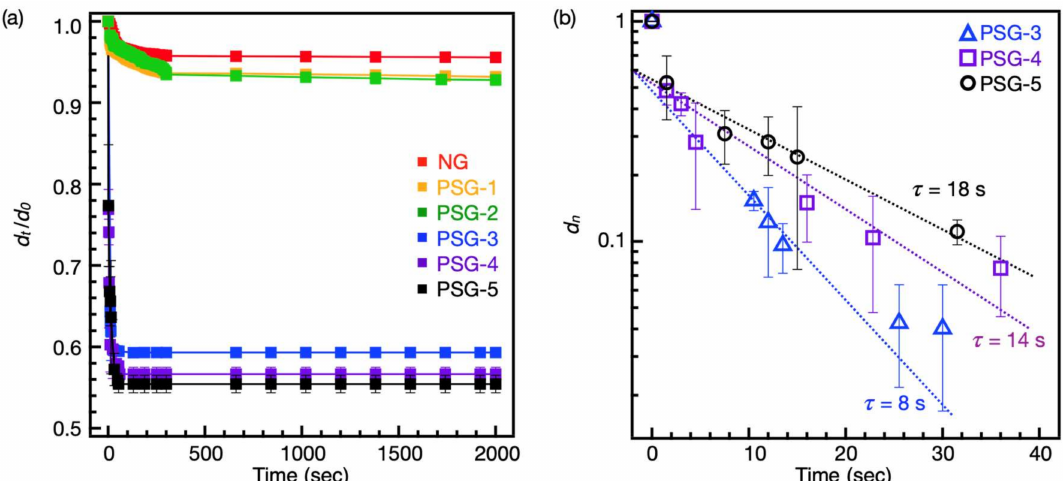
Figure 6. ( a ) Shrinking behaviors of NG, PSG-1, PSG-2, PSG-3, PSG-4, and PSG-5 after temperature jump from 20 ◦ C to 45 ◦ C, in which d t was hydrogel diameter at time t and d 0 was that of initial state. (NG, red; PSG-1, orange; PSG-2, green; PSG-3, blue; PSG-4, purple; PSG-5, black). ( b ) Plots of d n against time. The relaxation times were determined from the slope (1/ τ ) of the straight line (PSG-3, blue triangle; PSG-4, purple square; PSG-5, black